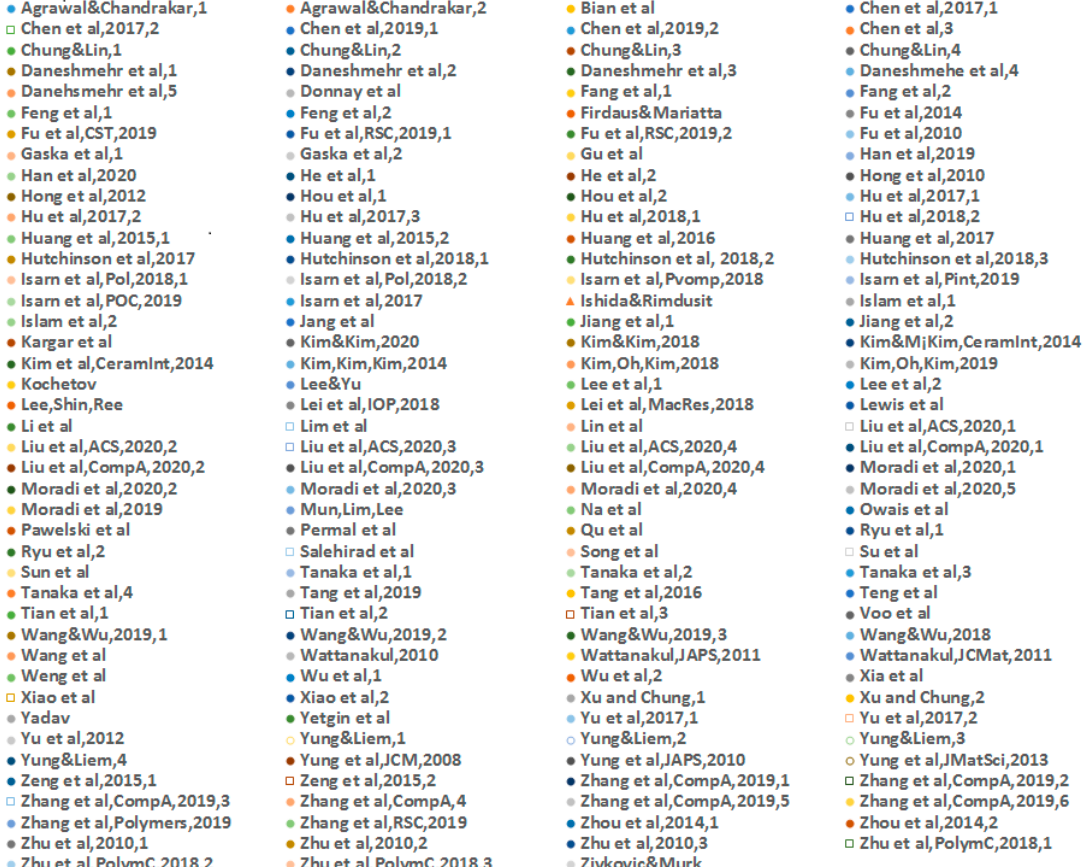
Figure 7. Thermal conductivity of epoxy-BN composites as a function of the BN content by weight. Data taken from references [54,57,59–159]. Open circles refer to data from references [54,151], open squares refer to data from references [89,90,114,116,125,127,132,143,147,153,158]. The dashed trend lines indicate the overall tendency for the dependence of thermal conductivity on BN content (excluding the data represented by the open circles): an upper trend line, below which more than 95% of the values fall; and a lower trend line, below which fewer than 5% of the values fall. The intermediate trend line is an approximation to the upper limit for isotropic samples.